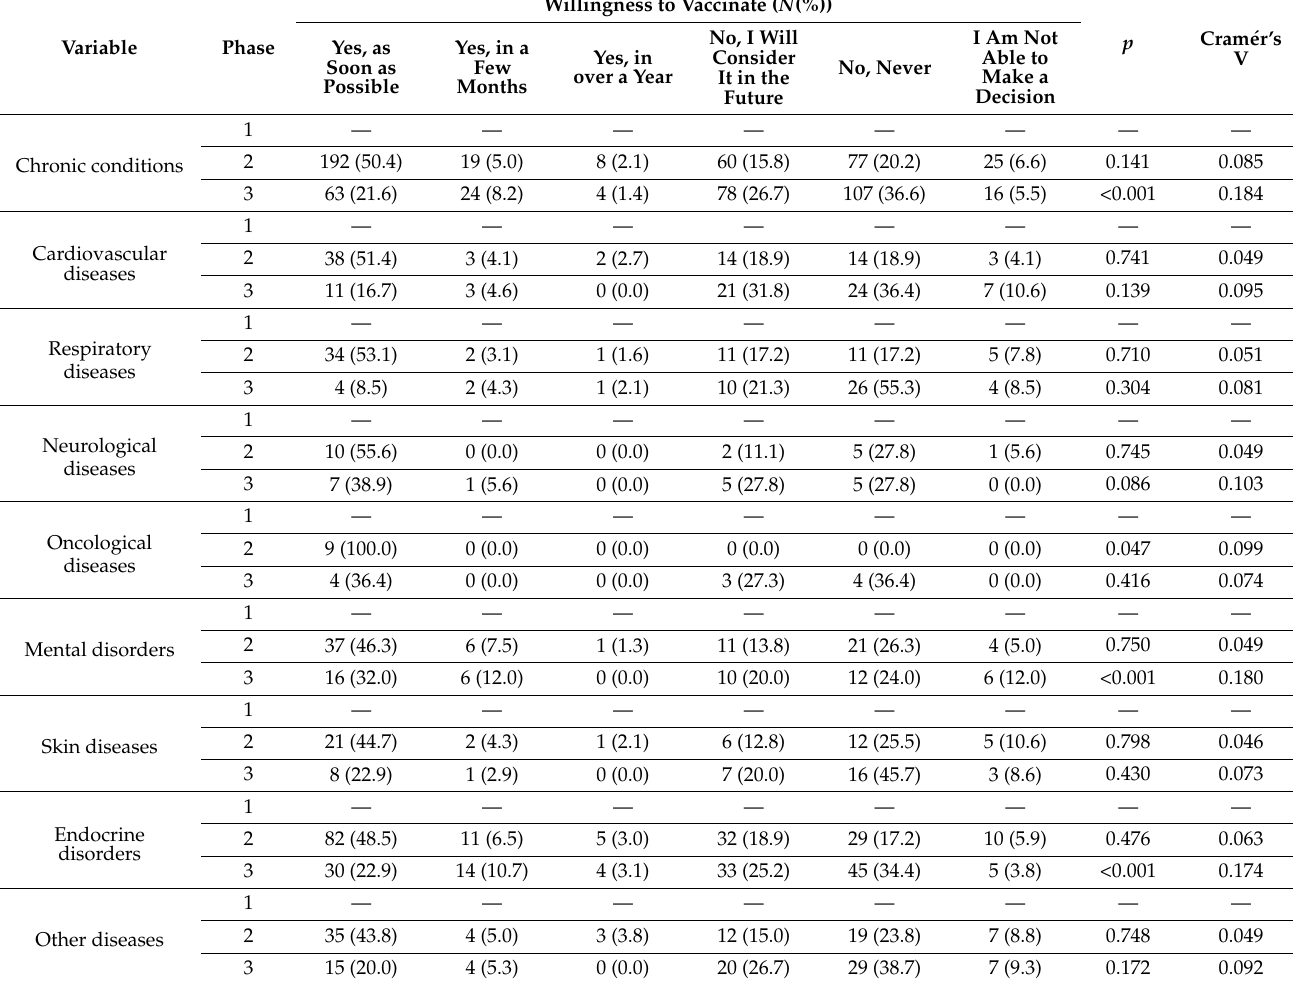
Table 3. Chronic diseases in the context of willingness to be vaccinated against